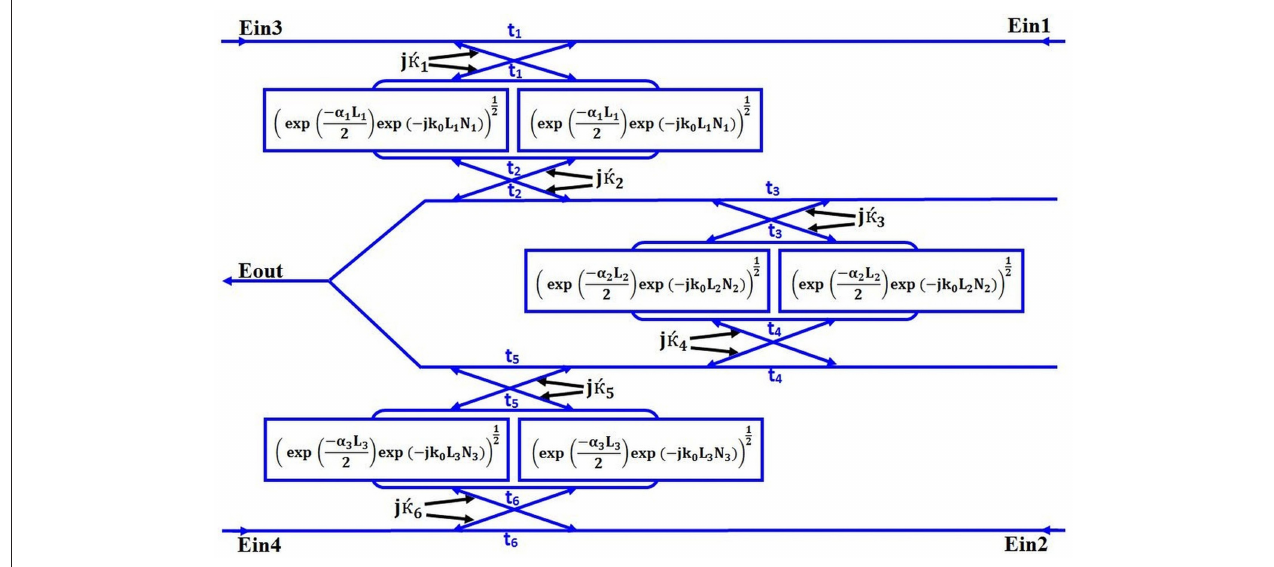
FIGURE 2 | The mathematical model of the switch. The input Y-splitters are omitted to give a greater clarity to the model.